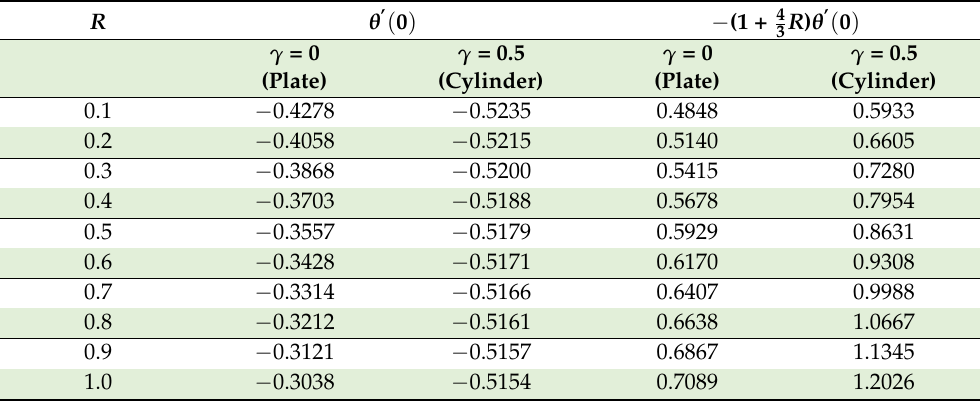
Table 5. Effect of R on Nusselt